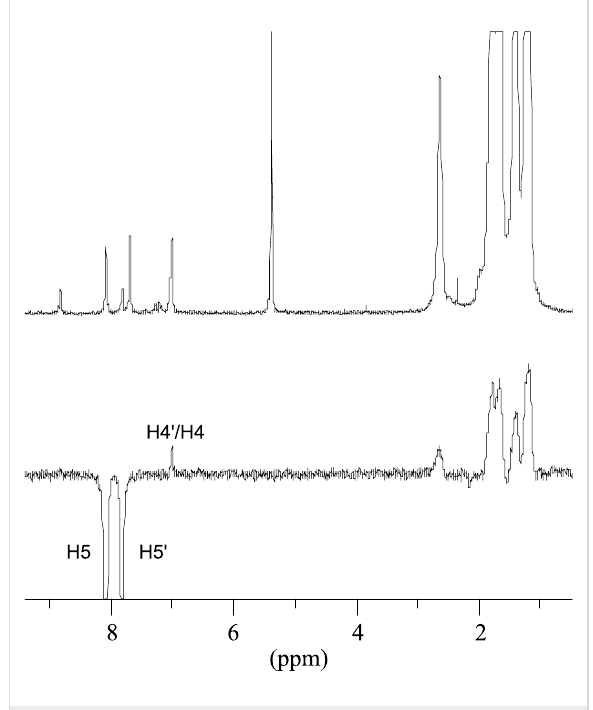
Figure 4: Olefin and alkyl group region of the 1 H NMR (top) and NOE difference spectrum (bottom) of 1e in CD 2 Cl 2 at − 40 °C, saturating the thienyl-H5 signal at δ = 8.07